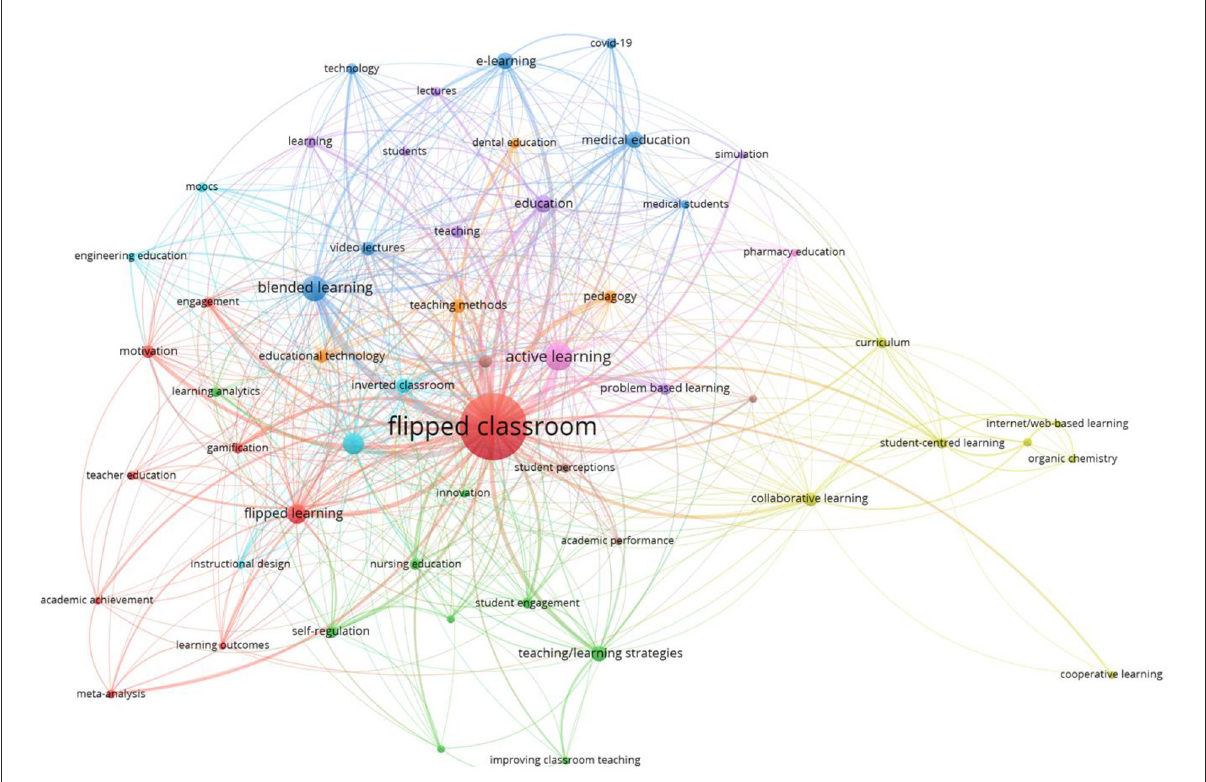
FIGURE7 Network map. Source: Created by authors with